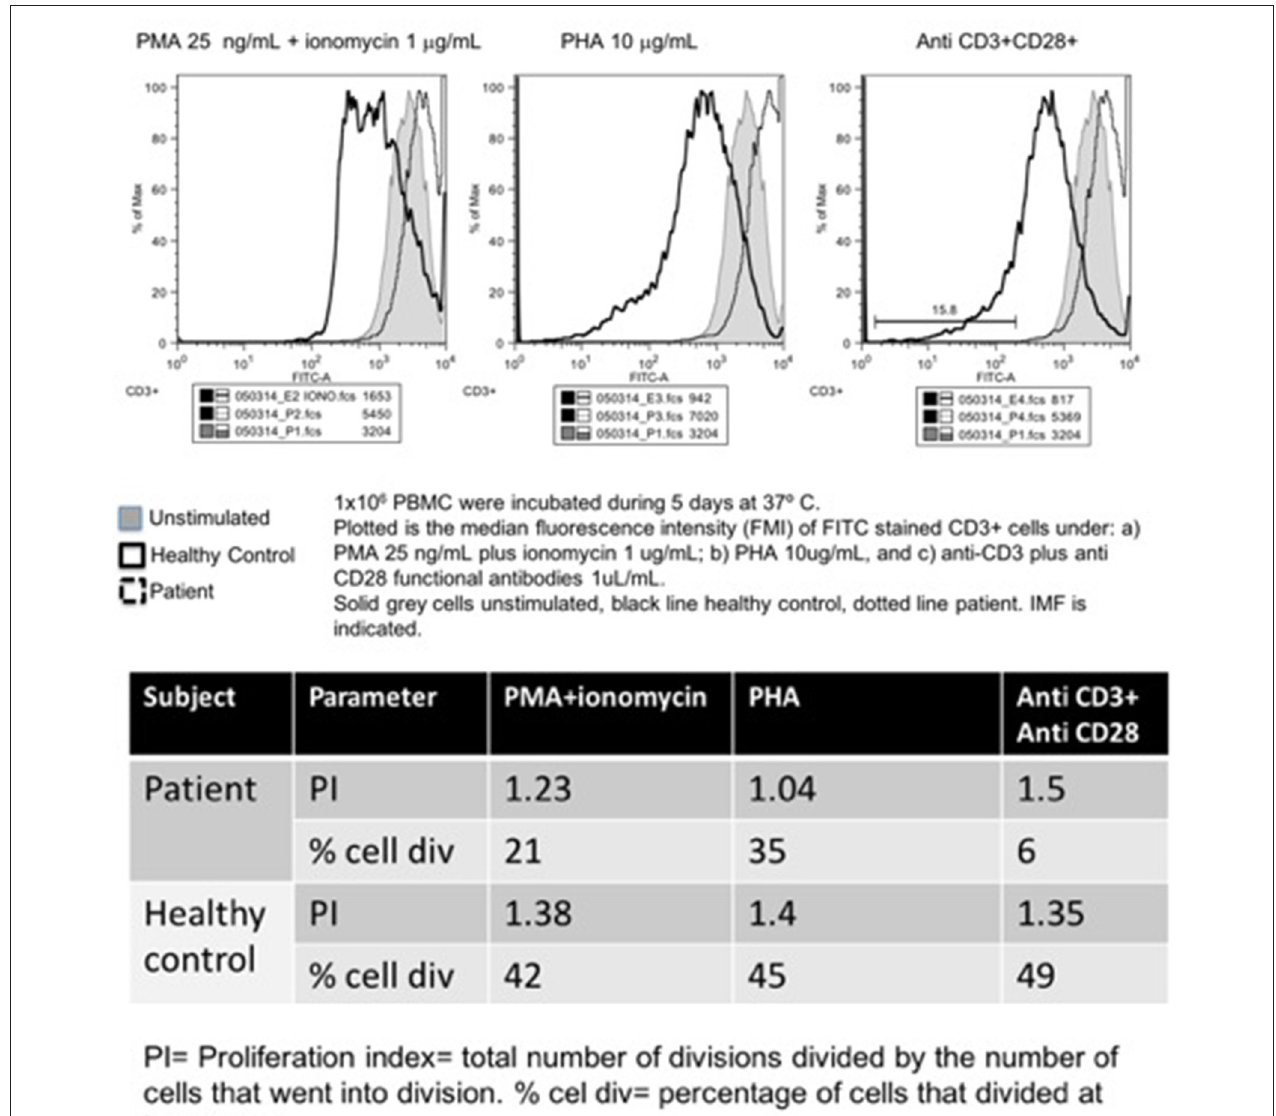
FIGURE 3 | Carboxyfluorescein succinimidyl ester lymphoproliferation assay, plot ( upper panel ), and indexes ( lower panel